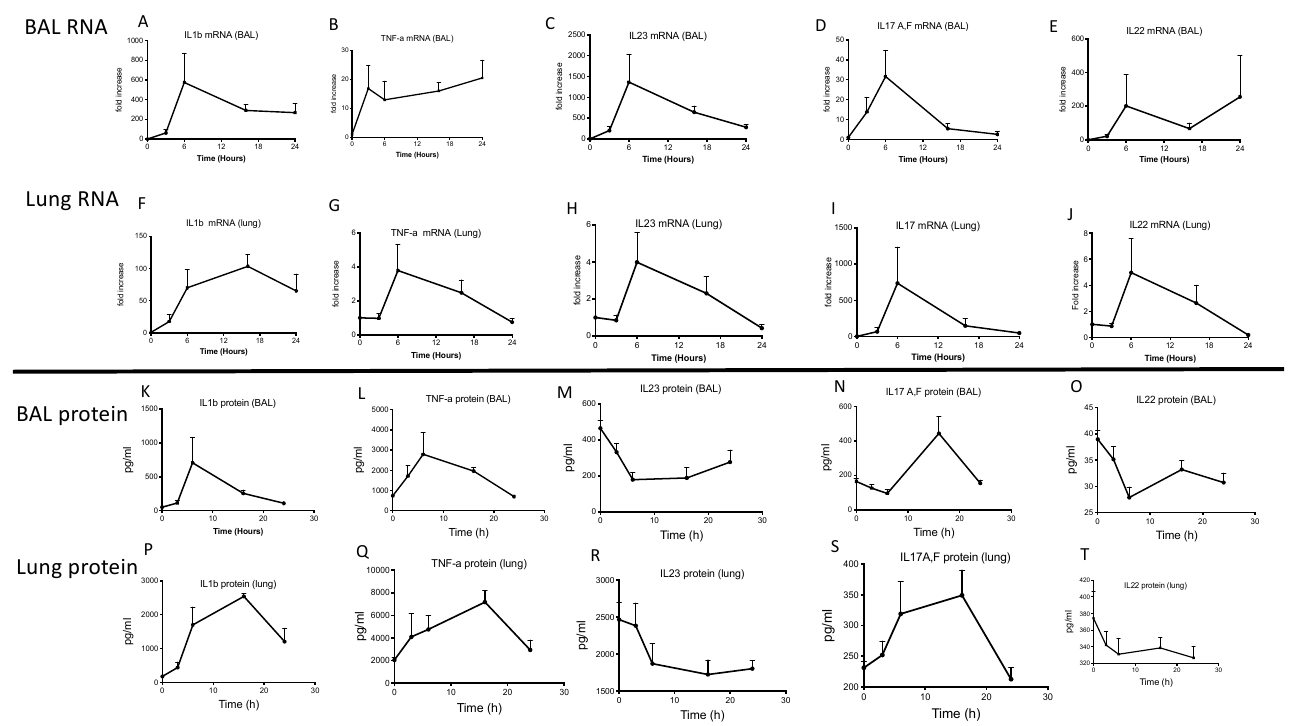
Figure 6. A kinetic study shows that IL-23 and IL-22 protein levels are down-regulated at an early time point following PAO1 lung infection. Male C57/Bl6 WT mice were infected with 10 7 cfu ( n = 7 for each time point). At each time point, mice were culled, and their lungs were recovered. One lobe of the lung was homogenized in PBS in FastPrep-24 D tubes. After centrifugation, supernatants were re- covered for ELISA analysis of cytokines. The other lobe was used for RNA preparation and cytokine gene expression. In parallel, BAL was performed, and after centrifugation, the cell pellet was used for RNA cytokine gene expression, while the supernatant was ana- lyzed for cytokine protein content (ELISA). Each point represents the mean ( n = 7) +/− SD. Whether this was caused directly by neutrophils or P.a virulence factors was then investigated. Indeed, we and others have previously shown that virulence factors, includ- ing LasB (a metalloprotease secreted by the type 2 secretion system of P.a ), can target in- nate immunity [3,4,17–23]. Firstly, we demonstrated that MPI alveolar macrophages treated with PAO1 WT secretome (SEC) down-regulated IL-23 accumulation in superna- tants compared to cells treated with PAO1 ∆LasB SEC (Figure 7A). A similar picture was obtained when BMDMs were treated with either WT or ∆LasB PAO1 SECs or when these cells were infected with live WT or mutant bacteria (Figure 7B). Expectedly, IL-22 was detected neither in MPI macrophages nor in BMDMs (not shown). To further assess whether IL-22 and IL-23 could be targeted by either LasB or NE, we used an artificial